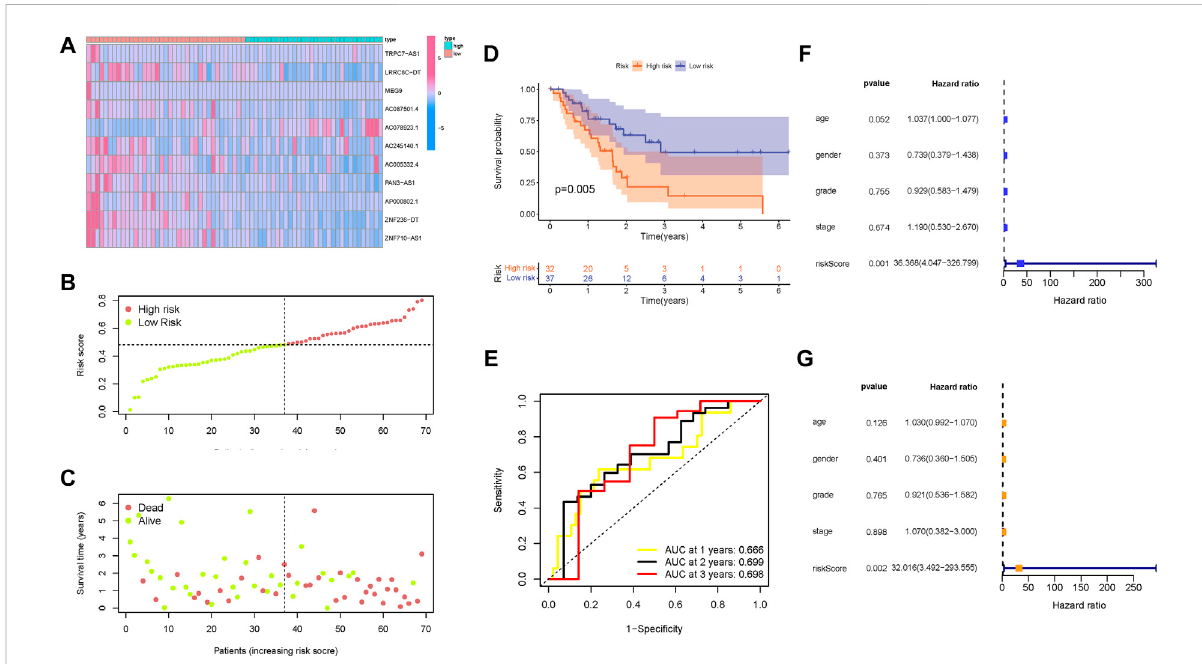
FIGURE 7 Validation of theprognostic valueof the risk signature in the testing group. (A) Heatmap presents the expression pattern of 11 hub m6A-related lncRNAs in each patient, where the colors yellow to blue represented alterations from high expression to low expression, respectively. (B) Distribution of the m6A-related lncRNA signature risk score. (C) Survival status and interval of PDAC patients. (D) Kaplan – Meier curve analysis presenting a difference in overall survival between the high-risk and low-risk groups. (E) Areas under curves (AUCs) of the risk scores for predicting 1-, 2-, and 3-year overall survival time. (F) Univariate Cox regression results of overall survival. The length of the horizontal line represents the 95% con fi dence interval for each group. The vertical dotted line represents the hazard ratio (HR) of all patients. (G) Multivariate Cox regression results of overall survival. The length of the horizontal line represents the 95% con fi dence interval for each group. The vertical dotted line represents the hazard ratio (HR) of all